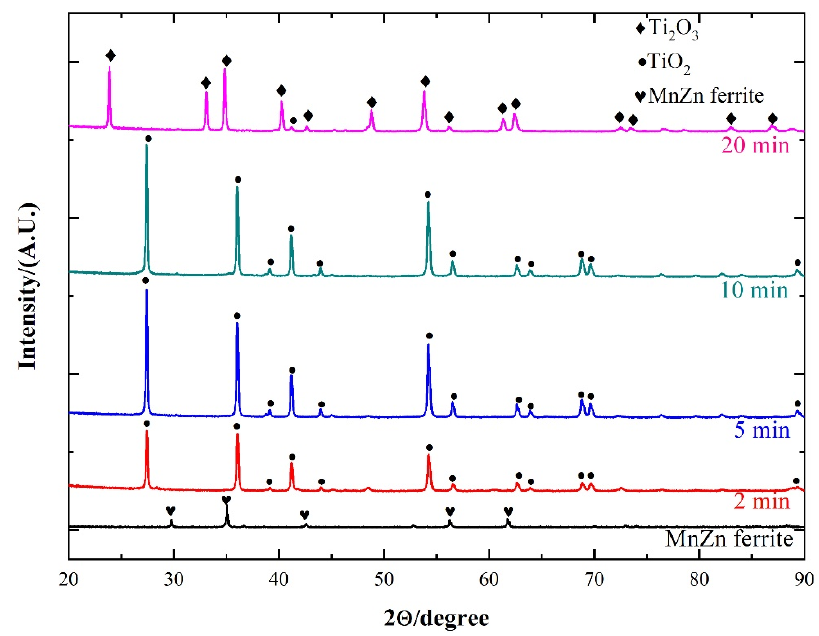
Figure 7. XRD patterns of MnZn ferrite and MnZn ferrite immersed in molten salt for different times.